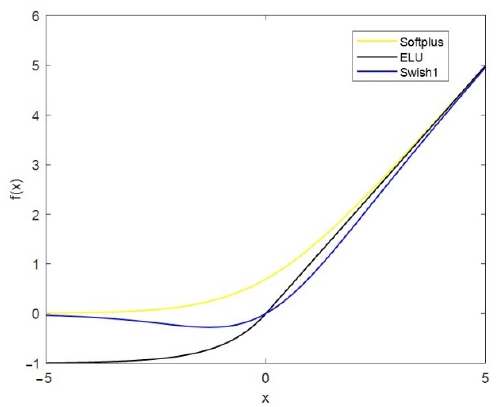
Figure 11. Activation function curves of ELU , Softplus, and Swish1, which are related to e-index.